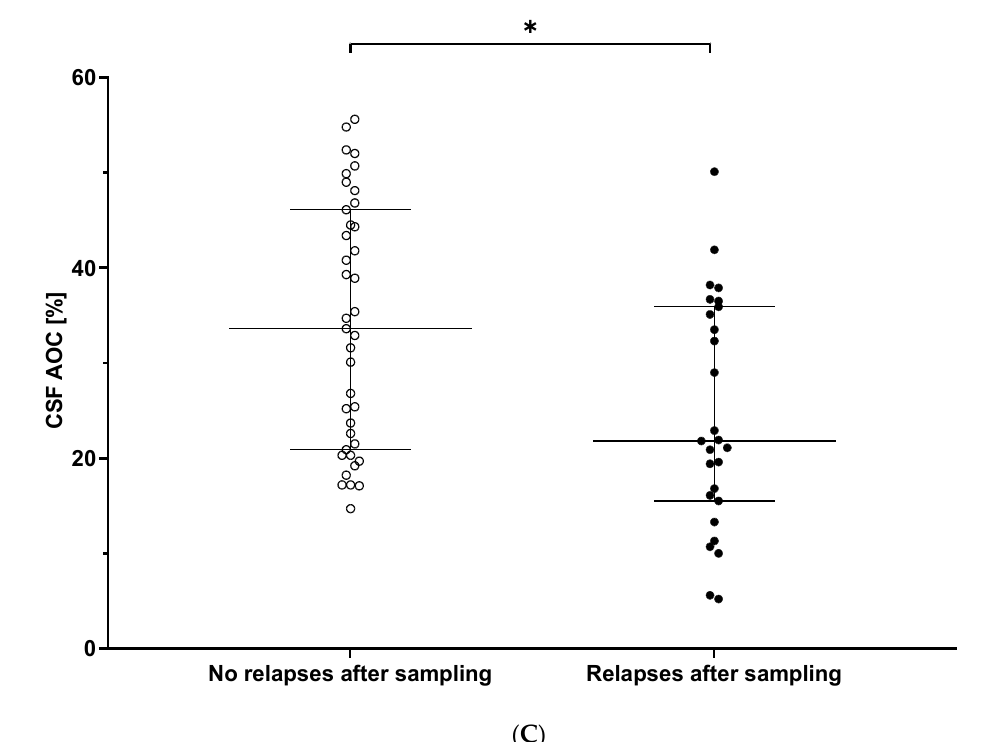
Figure 2. Decreased CSF AOC is associated with physical disability and predicts disease progression in MS. ( A ) CSF AOC was significantly lower in patients presenting with EDSS ≥ 3 ( n = 17) those those with lower physical disability ( n = 49) ( p = 0.002). ( B ) CSF AOC correlated negatively with the EDSS at time of sampling ( n = 66, r = − 0.365, p = 0.004). ( C ) Graphical display of the association between CSF AOC and the occurrence of relapses after sampling. A decrease in CSF AOC was significantly associated with an increased likelihood of exhibiting new clinical relapses post sampling, as shown by binary logistic regression (exp( β ) = 0.929, p = 0.033). During the follow-up time, 27 CIS/RRMS patients underwent a new clinical relapse and 39 did not. AOC = antioxidative capacity; CIS = clinically isolated syndrome; CSF = cerebrospinal fluid; EDSS = Expanded Disability Status Scale; RRMS = relapsing-remitting multiple sclerosis. Significance ( p < 0.05) was assessed by Mann–Whitney U test, partial Spearman correlation (covariates age at sampling, sex, sample storage time, time between sampling and EDSS examination), or binary logistic regression. * p < 0.05.